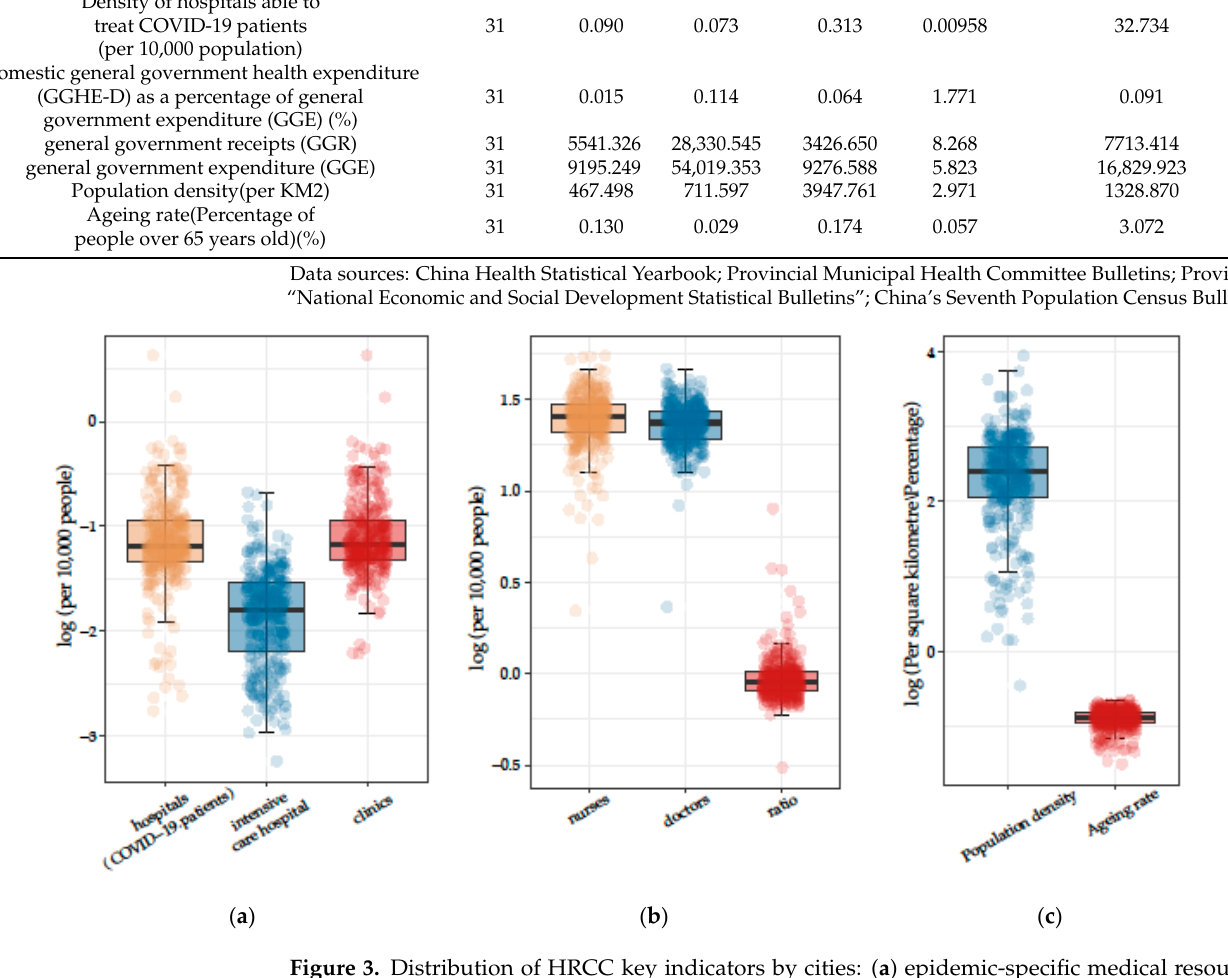
Figure 3. Distribution of HRCC key indicators by cities: ( a ) epidemic-specific medical resources; ( b ) medical workforce resources; ( c ) population indicators (data sources: Provincial Health Statistical Yearbook; Municipal Health Committee Bulletins; Municipal “National Economic and Social Development Statistical Bulletins”; China’s Seventh Population Census Bulletin).